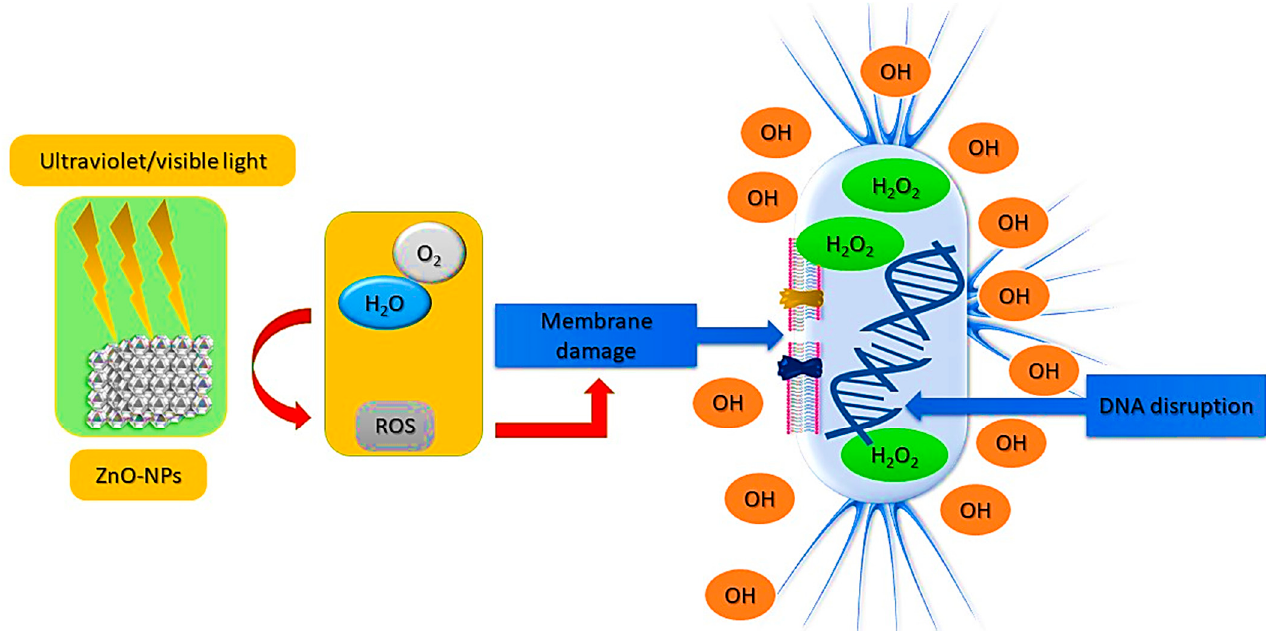
Figure 6. Mechanism of ROS production from ZnO-NPs and their bactericidal effect.